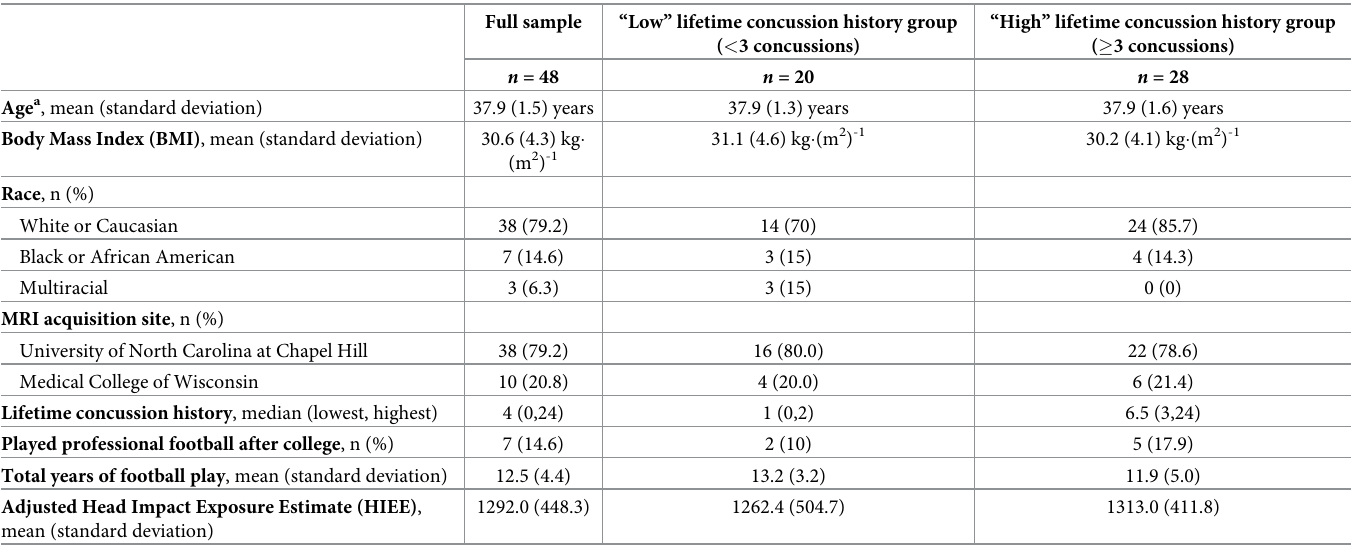
Table 2. Participant